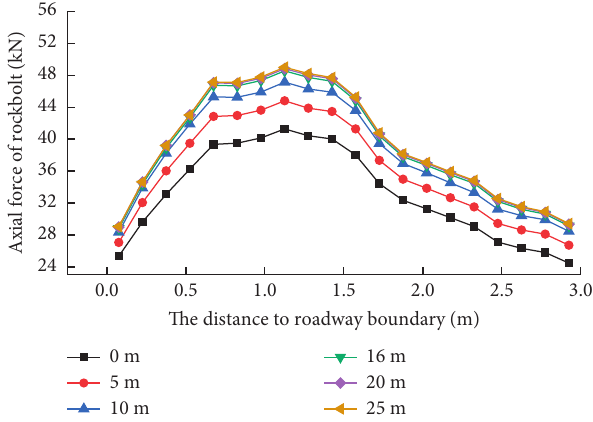
Figure 14: Axial force of rockbolt with different water injection section lengths.